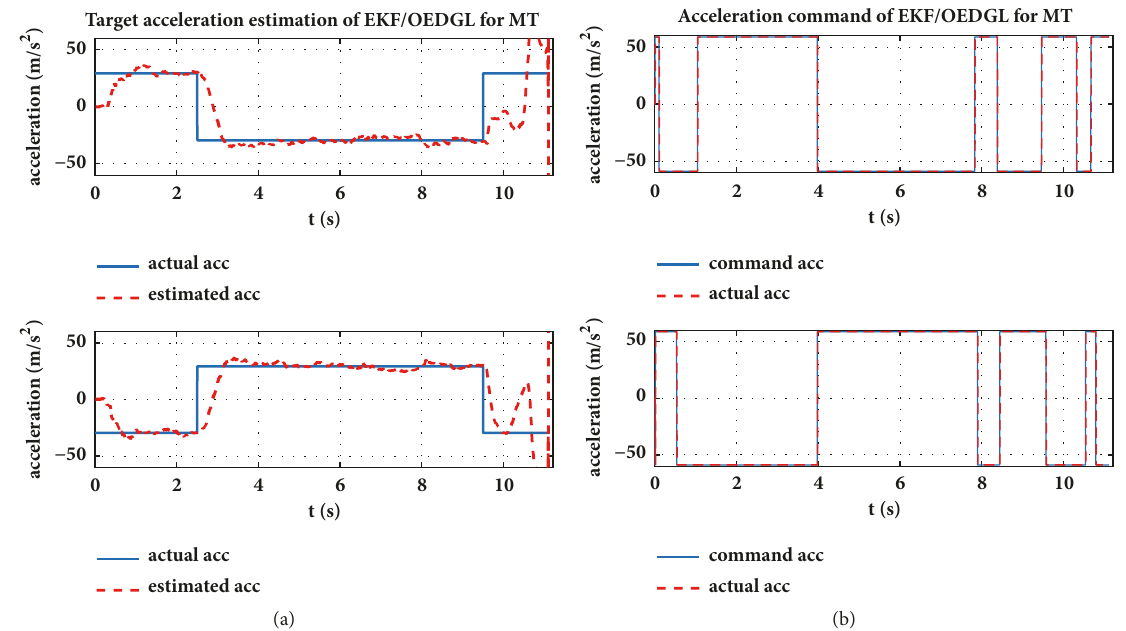
Figure 12: Target acceleration estimation and acceleration command of EKF/OEDGL for